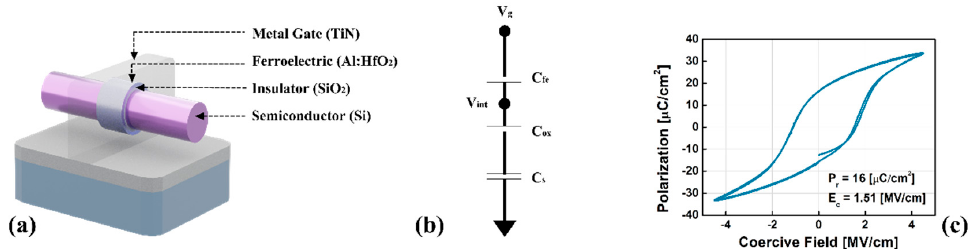
Figure 1. ( a ) Bird’s-eye view and ( b ) equivalent capacitive model of MFIS-structured NF-JL-NWFETs. ( c ) Experimentally measured polarization versus coercive field of 10 nm-thick Al:HfO 2 (HAO) capacitor.